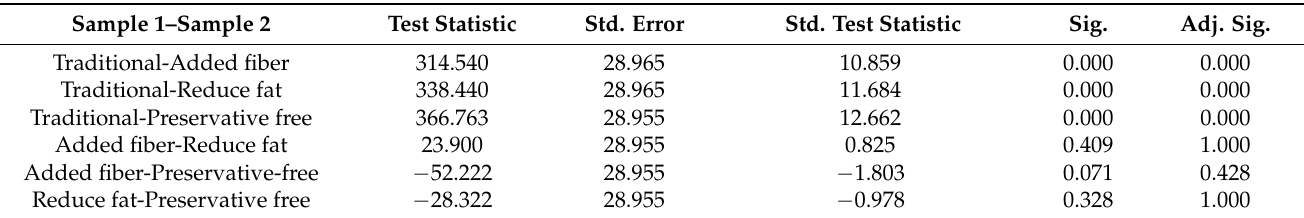
Figure 2. Median test for health perception of meatballs. Table 4. Paired comparison test for meatballs perception of